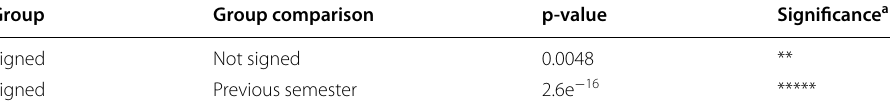
Table 8 Results of the unpaired two‑sample Wilcoxon test on final mark distribution for Introduction to